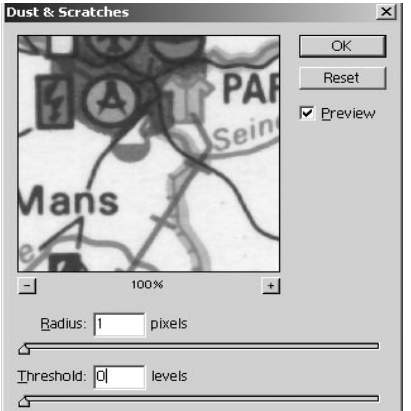
5 pav . Filtro Dust&Scratch režim ų nustatymo langas Fig 5. Properties of filter